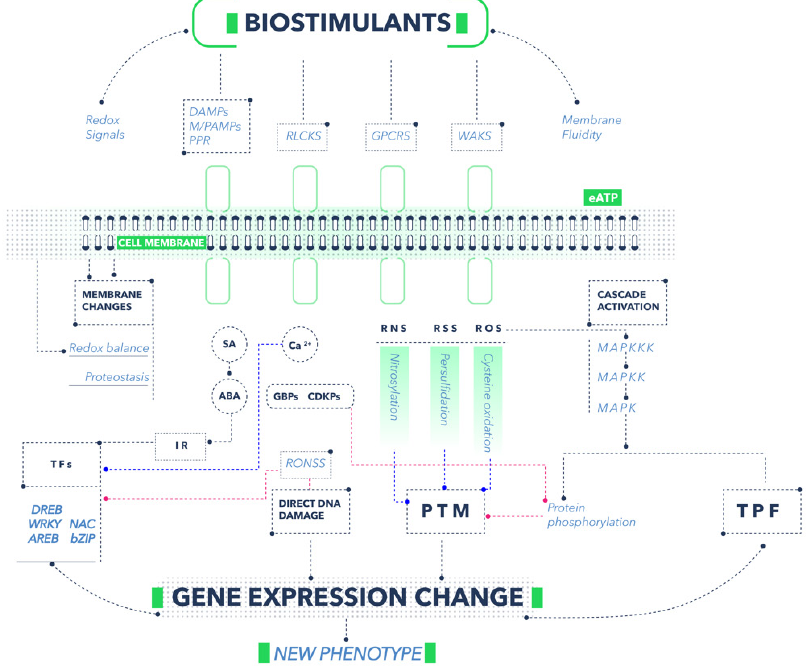
Figure 2. Mechanisms of action of biostimulants. The abbreviations used are defined in the text of